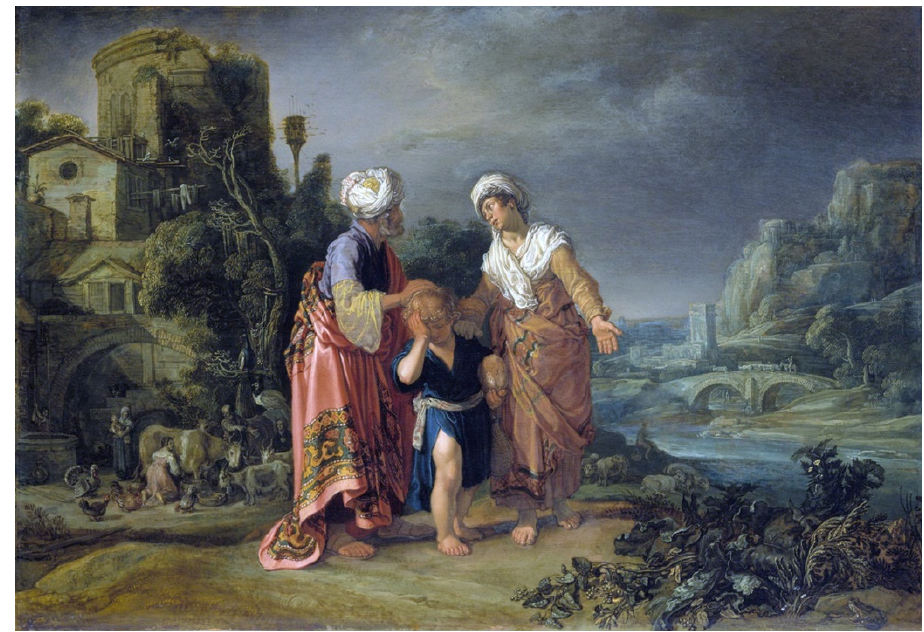
Figure 11. Pieter Lastman, 1612, Hamburg, Kunsthalle.